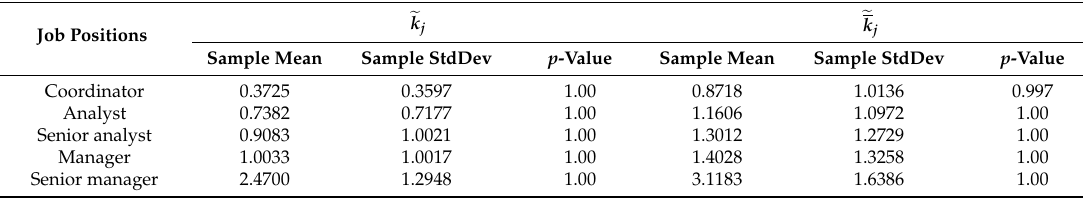
Table 11. The characteristics of generated random numbers by